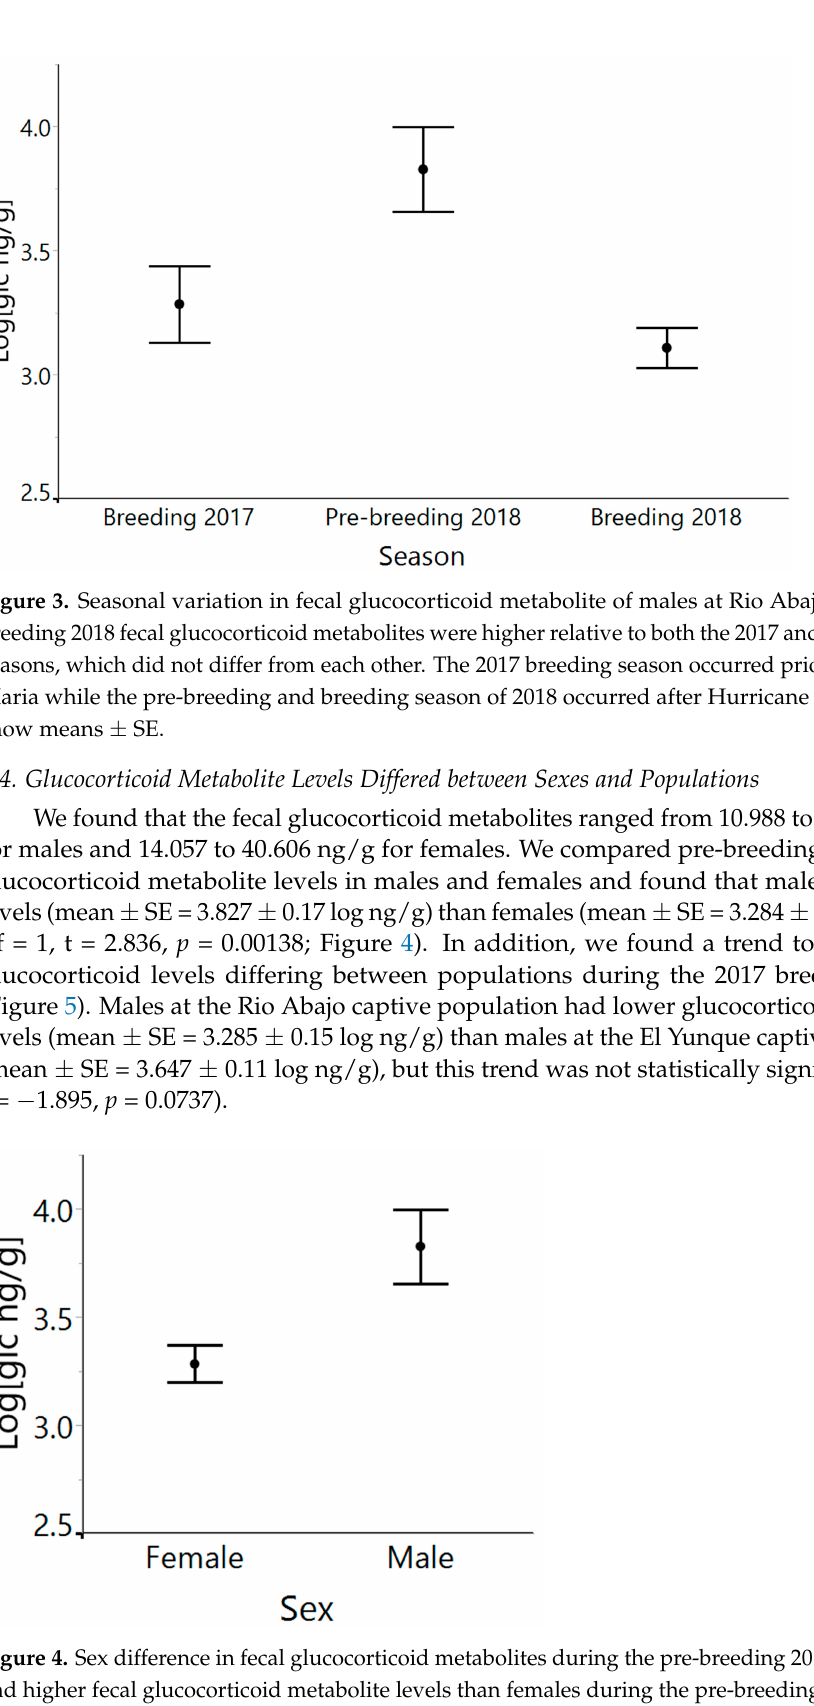
Figure 5. Populations comparison in fecal glucocorticoid metabolites between males in the Rio Abajo (12) and El Yunque (9) captive populations during the 2017 breeding season. Graphs show means ± SE. 4. Discussion Captive breeding can be an important tool for many conservation efforts. Under- standing how a threatened species is affected by captive conditions is critical for conser- vation success [16]. We evaluated fecal glucocorticoid metabolite levels of captive popu- lations of Puerto Rican parrots using a newly validated commercial corticosterone assay